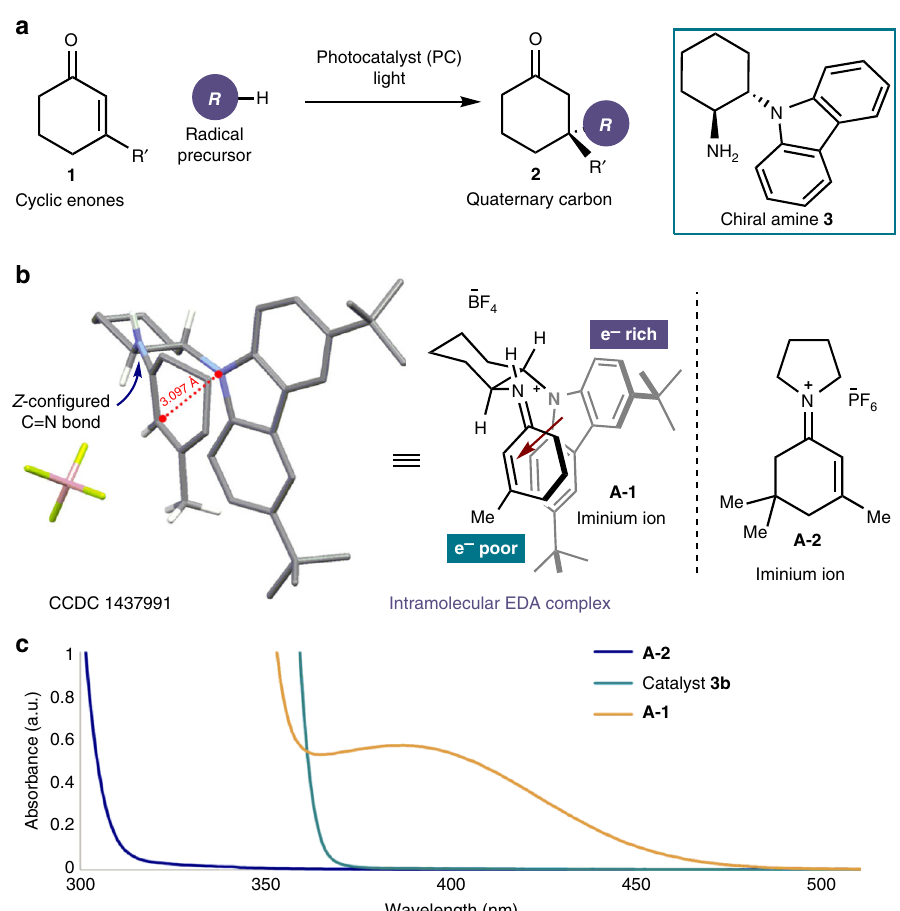
Fig. 2 Background and initial insights. a Original strategy for the enantioselective iminium ion trapping of radicals based on the combination of a carbazole amine catalyst 3 and an exogenous photoredox catalyst ( PC ). b X-ray crystal structure of the carbazole-based iminium ion A-1 . c UV – Vis spectra of the carbazole catalyst 3b (structure in Table 1) and iminium ions A-1 and A-2 [1.0 mM] in CH 3